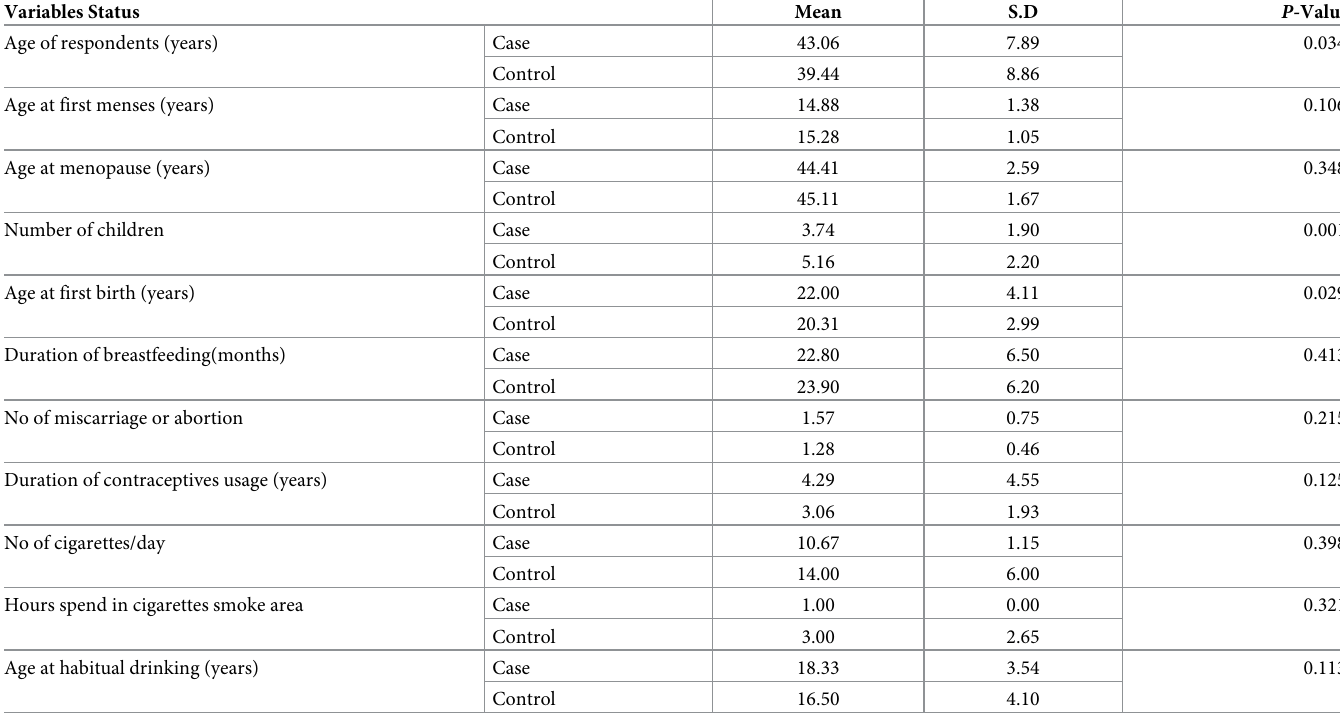
Table 2. Status of the biological and behavioral risk factors of the study